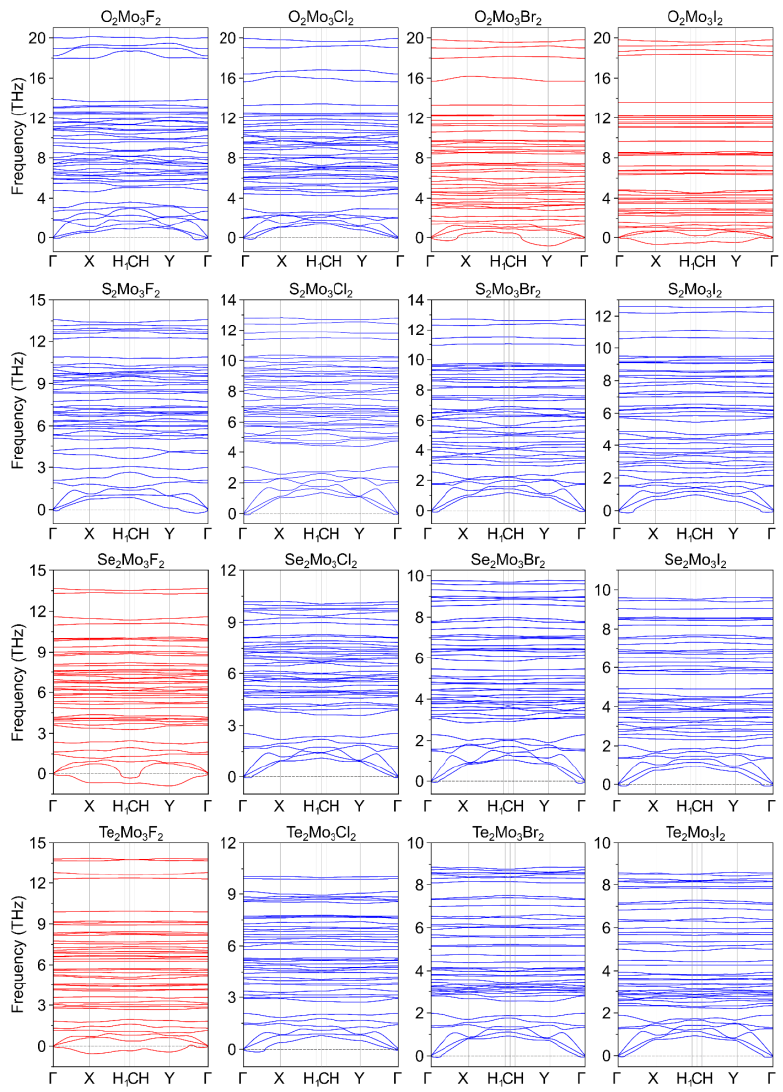
Figure 3. Phonon dispersion spectra for Ch 2 Mo 3 Hal 2 (Ch = O, S, Se, Te and Hal = F, Cl, Br, I) Chevrel phases.